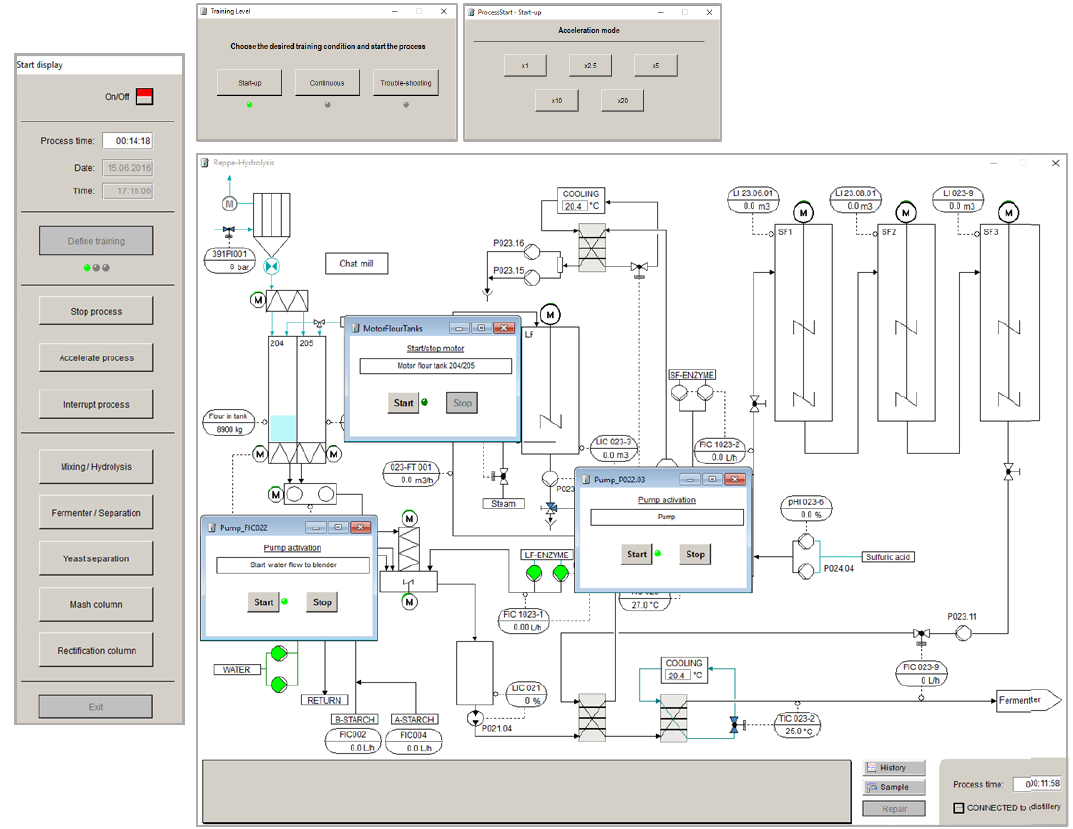
Figure 6. The GUIs for hydrolysis with sub-windows. The virtual process was started via the start display (“Define training”) by choosing the training condition “Start-up” and a 20-fold acceleration mode. The start display provides different buttons in order to open required GUIs as well as to stop, accelerate or interrupt the process. Motors, pumps and controllers were set and raw material blended. Active pumps are shown in green.